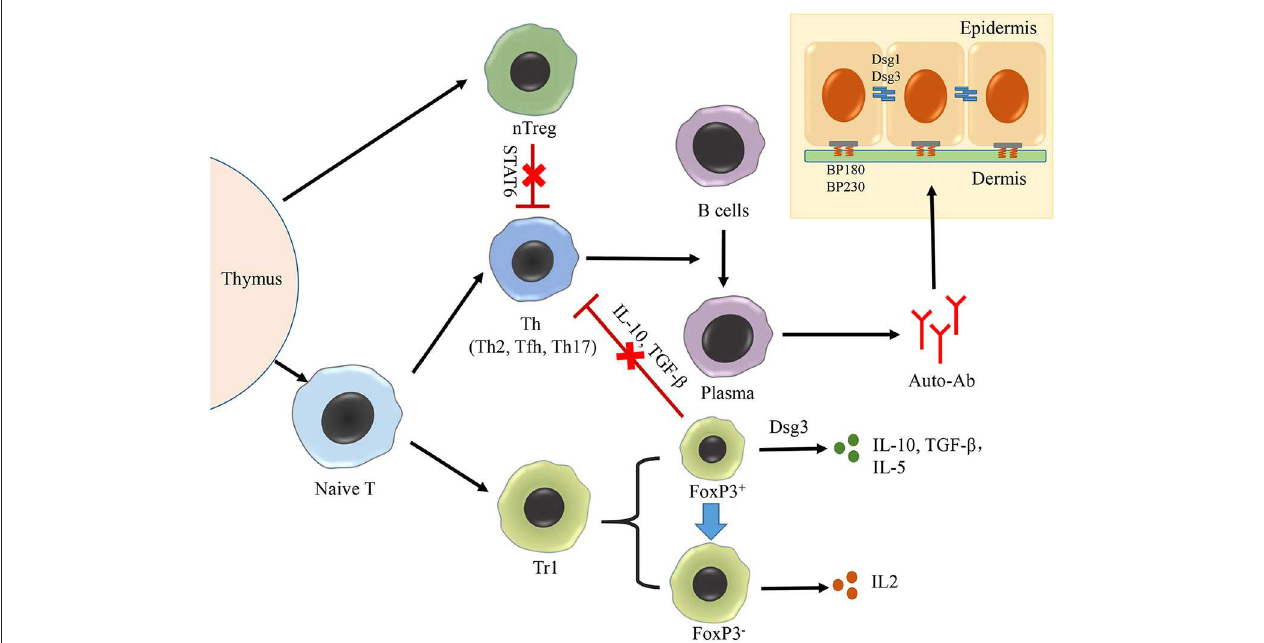
FIGURE 2 | Role of treg cells in AIBD. The production of autoantibodies by plasma cells is the crucial process in the pathogenesis of both PV and BP, in which Th–B cell interaction plays an important role. Treg cells can be divided into two groups: nTreg cells and iTreg cells. nTreg cells number is decreased in PV, which have a negative correlation with Th17 cells. nTreg cells could suppress the functions of Th2 and Tfh cells on activing B cells in an STAT6-dependent manner, but they lost this function in BP. Additionally, Tr1 cells, the most intensively studied cell type of iTreg cells, could be divided into two subpopulations based on the cell size and granularity in PV. The smaller subset achieves the suppressing function by secreting IL-10, TGF- β in response to Dsg3. The larger subset loses the ability in response to Dsg3, exhibits a Th cell-like phenotype, and secretes